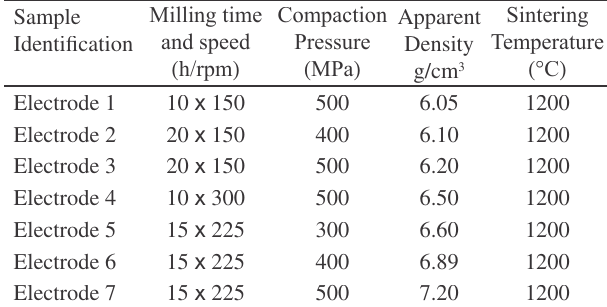
Table 1. Process parameters and apparent density of composite (Fe,C)-FeNbC samples.